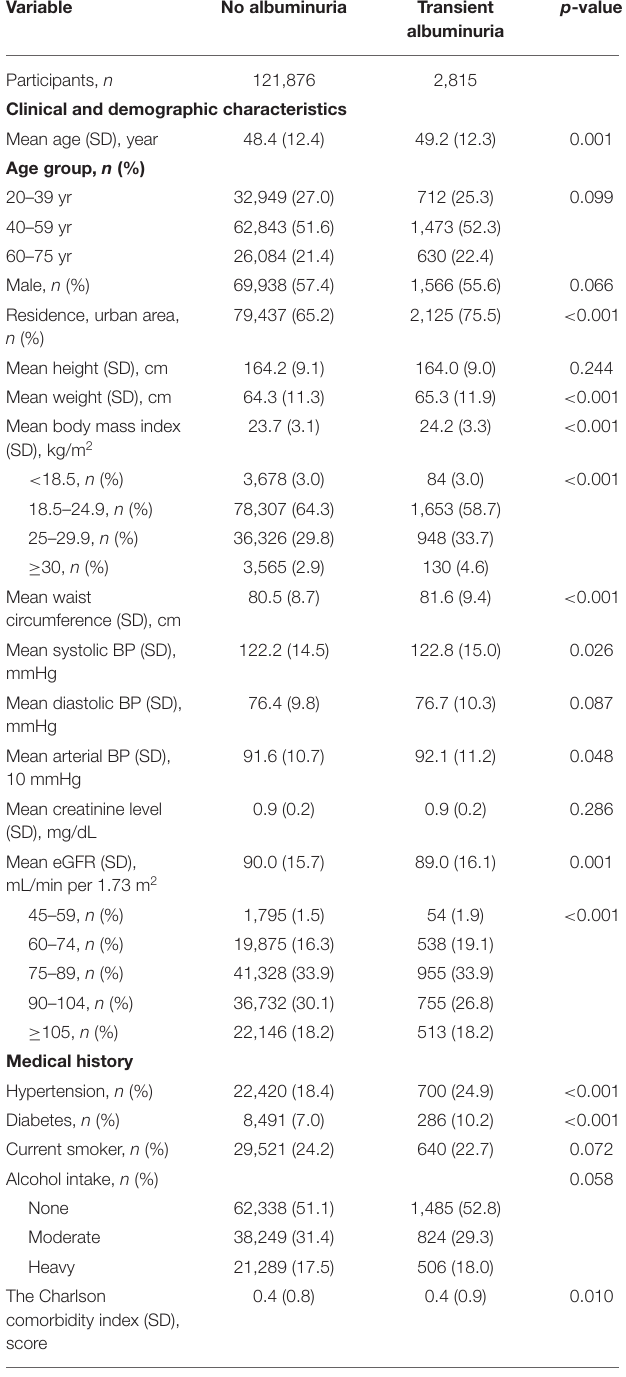
TABLE 1 | Baseline characteristics of participants in the no albuminuria and transient albuminuria